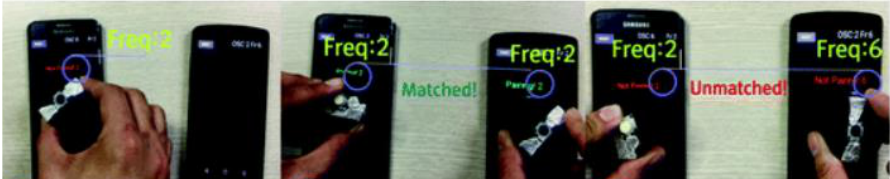
Figure 41. Application of tangible objects for pair smart devices